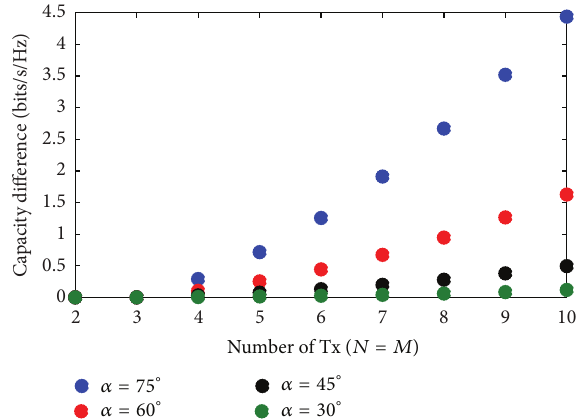
Figure3:Differencebetweenthemaximumtheoreticalcapacityand the actual achieved capacity by varying the number of transmitters ( 𝑁 = 𝑀 ) and the arc aperture 𝛼